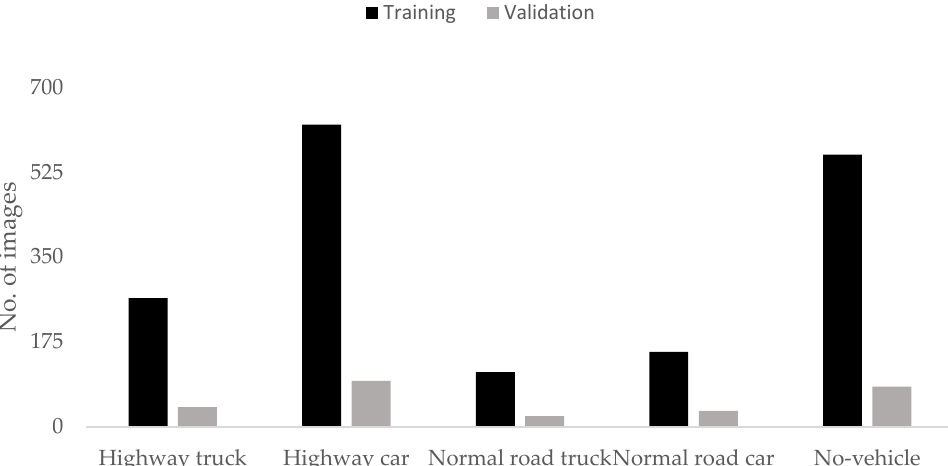
Figure 4. The collected large vehicle dataset divided into the training and validation.